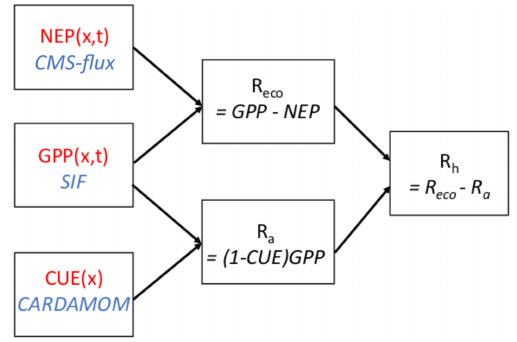
Figure 1. Schematic diagram of process used to calculate het- erotrophic respiration R he . Input datasets are outlined in red, and data sources are described in blue italics. Arrows indicate one flux is used to calculate another. Data sources are described in detail in Sect.